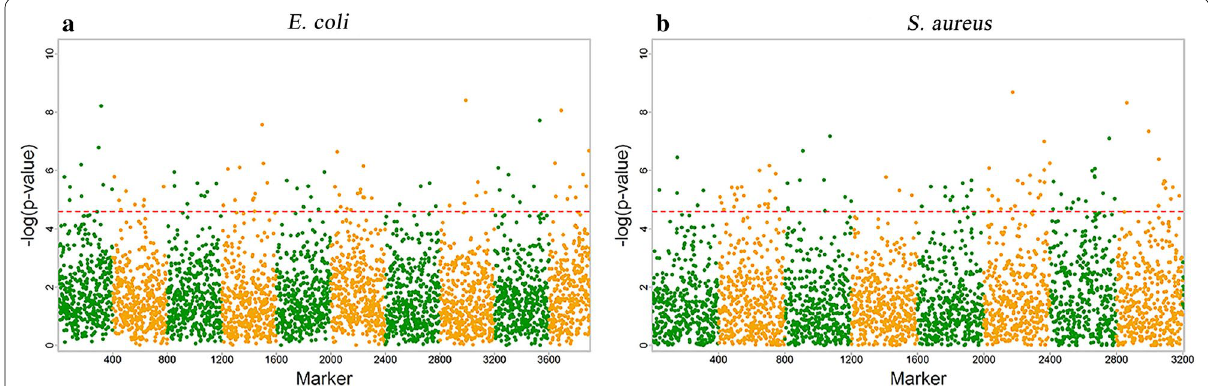
Fig. 2 Manhattan plots of GWAS results for E. coli and S. aureus in monoculture. a E. coli ; b S.